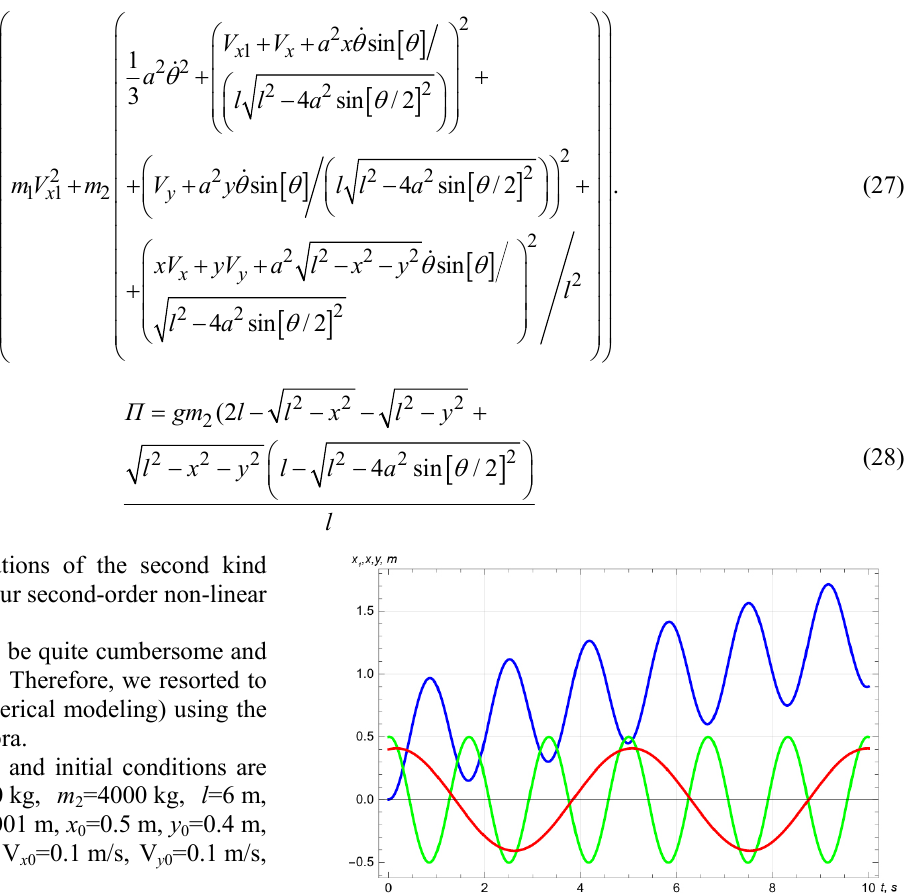
Figure 3. Graph of linear coordinates versus time: x1[t] – blue, x[t] – green, y[t] –